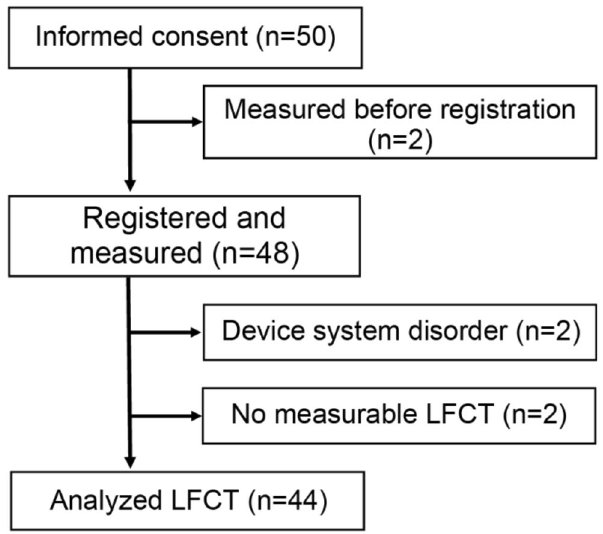
Figure 3. Patients flow diagram. We obtained informed consent from 50 patients. Two patients were excluded because they were accidentally measured LFCT before system registration. After registration, 48 patients were measured LFCT. Two patients were excluded because of the device system disorder. Finally, we evaluated LFCT from 46 patients; among them, 2 patients have no measurable LFCT. LFCT: lung to finger circulation time.